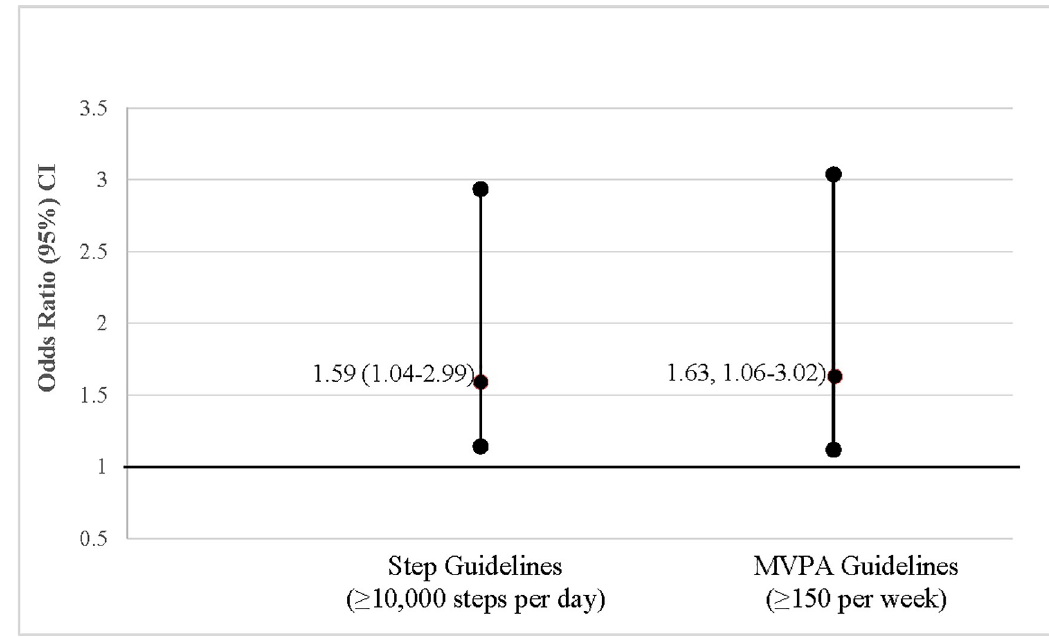
Fig 1. Log odds of meeting physical activity guidelines based on Walk Score � (OR, 95% Confidence Interval) � . Units for Walk Score = 10 (for each 10 unit increase in Walk